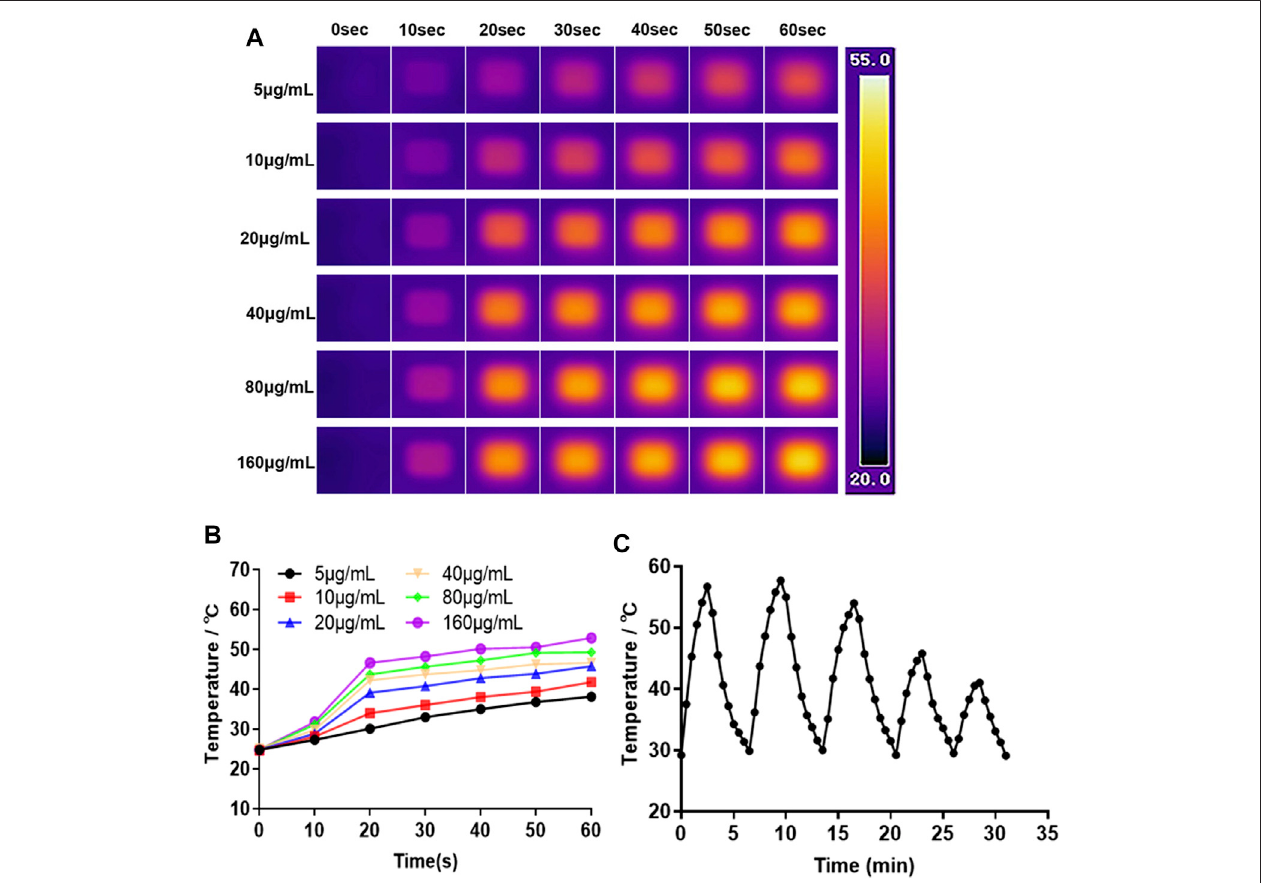
FIGURE 5 | The photothermal effect of the BID-liposomal nanocomposites. The thermographs (A) and corresponding heating curves (B) of the BID-liposomal nanocompositesat varied concentrationsupon808 nmlaserexposure (1 W/cm 2 )in96-wellplates.BID-liposomal nanocompositeswithdifferentconcentrationsofICG were assessed. (C) Heating curves of BID-liposomal nanocomposites subjected to repeated irradiation at 808 nm (1 W/cm 2 ).